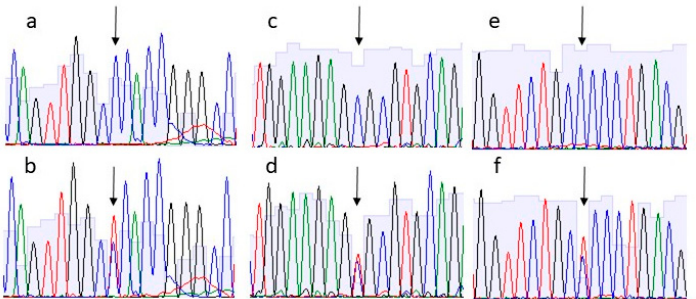
Figure 3. Electropherograms of the variants tested. Panel ( a , c , e) showing the wiltype variant of COL23A1, EMILIN3 and HDAC10 genes, respectively, present in the two healthy members of the family. Panel ( b , d,f ) showing the heterozygous variant in COL23A1, EMILIN3 and HDAC10 genes, respectively, identified in the two subjects with RC tears. Arrows indicate the site of substitution.